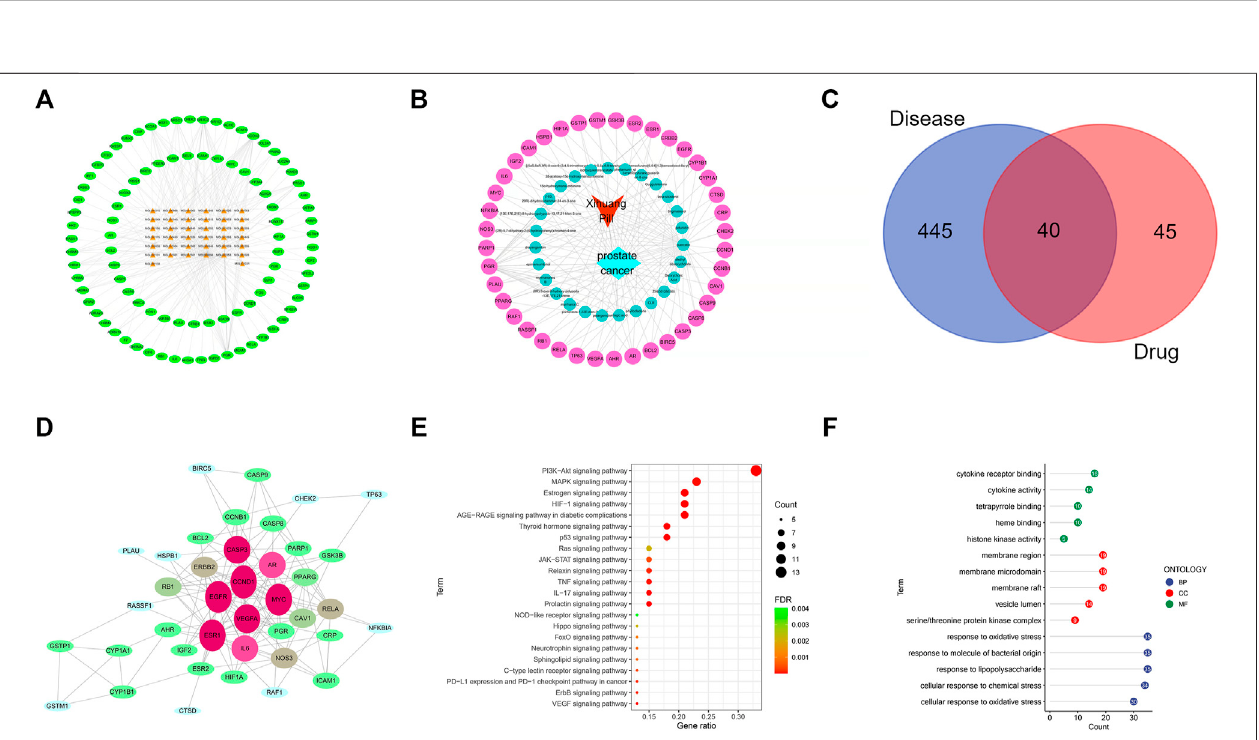
FIGURE 1 | The process of this research (IF, Immuno fl